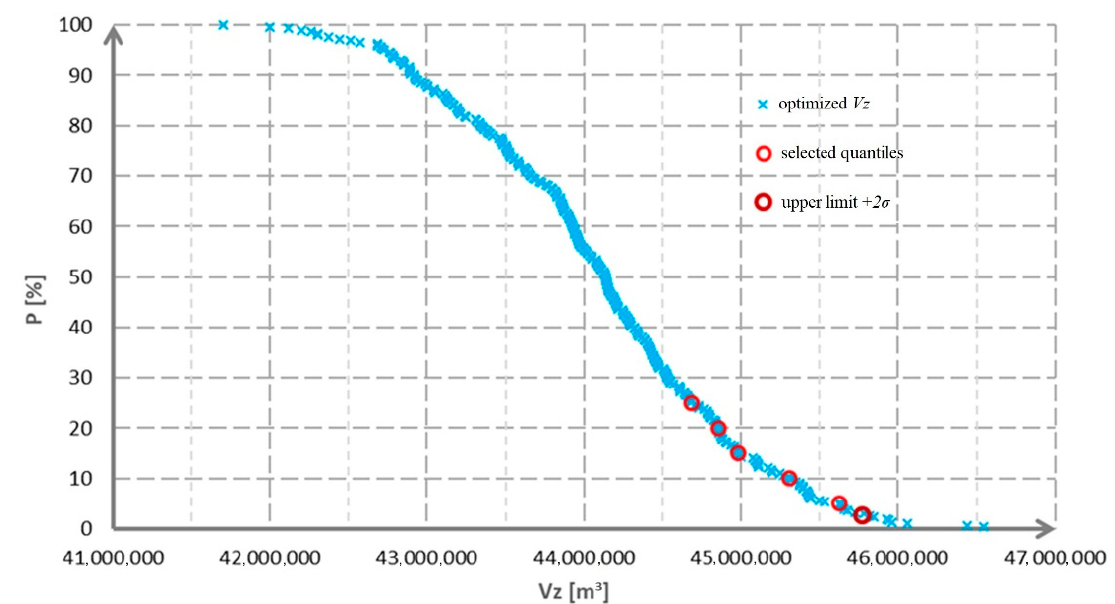
Figure 8. Optimal V Z values selected from the overshoot probability curve of the obtained optimized storage volumes of the Vír I reservoir.